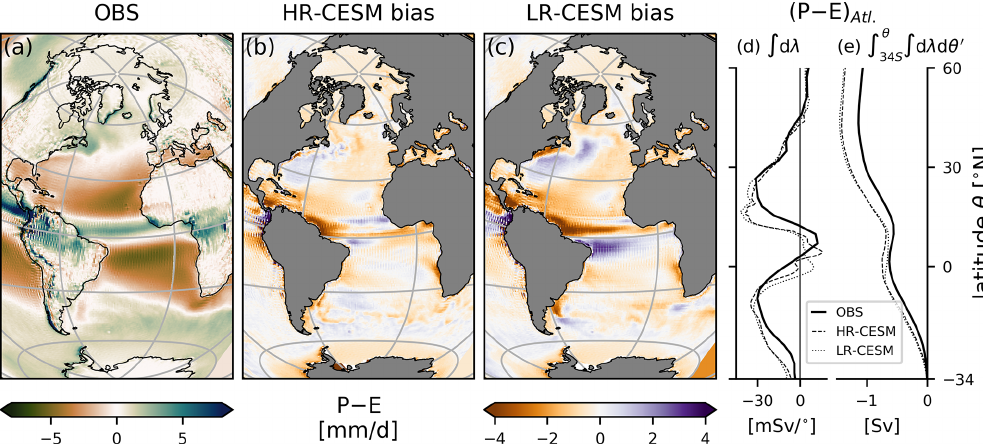
Figure 2. Precipitation minus evaporation: the observed ERA-Interim 1980–2010 climatology (a) and the biases of the HR-CESM (b) and LR-CESM (c) CTRL simulations. The zonally integrated P – E fluxes per degree latitude (d) and the implied freshwater transport due to the P – E fluxes (e) assuming zero transport at 34 ◦ S and constant salt content in the oceans. Note that this does not include runoff freshwater